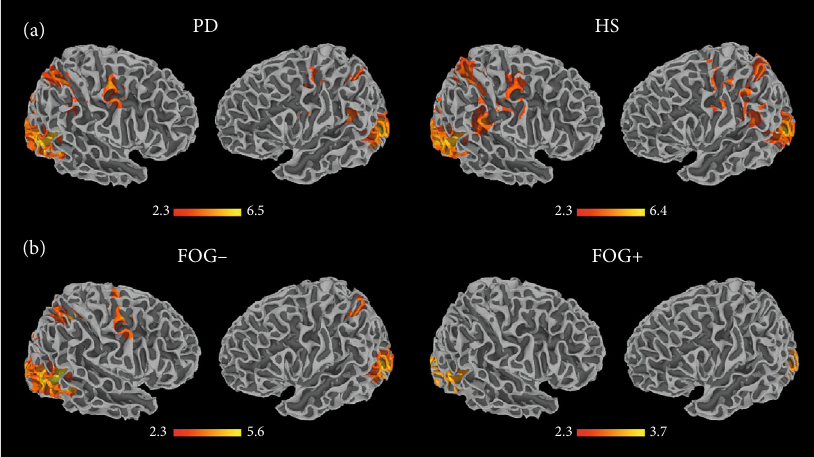
Figure 2: Cortical activity during AO of gait in the (a) whole group of PD patients and in the HS group and in (b) FOG- and FOG+ patients. The results are cluster corrected for multiple comparisons ( Z ≥ 2 : 3 , p < 0 : 05 ) and are shown in MNI